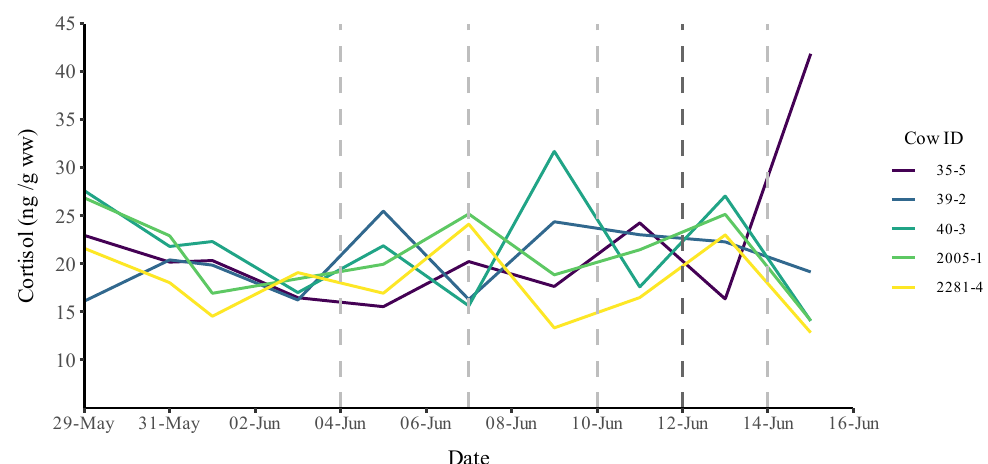
Figure 4. Cortisol concentrations in manure from the five cows sampled in the period of 29 May to 15 June. Training for virtual fencing started on 29 May; from 12 June onward, the fence was solely virtual. Coloured lines indicates each cow. Vertical lines: changes in fence position.